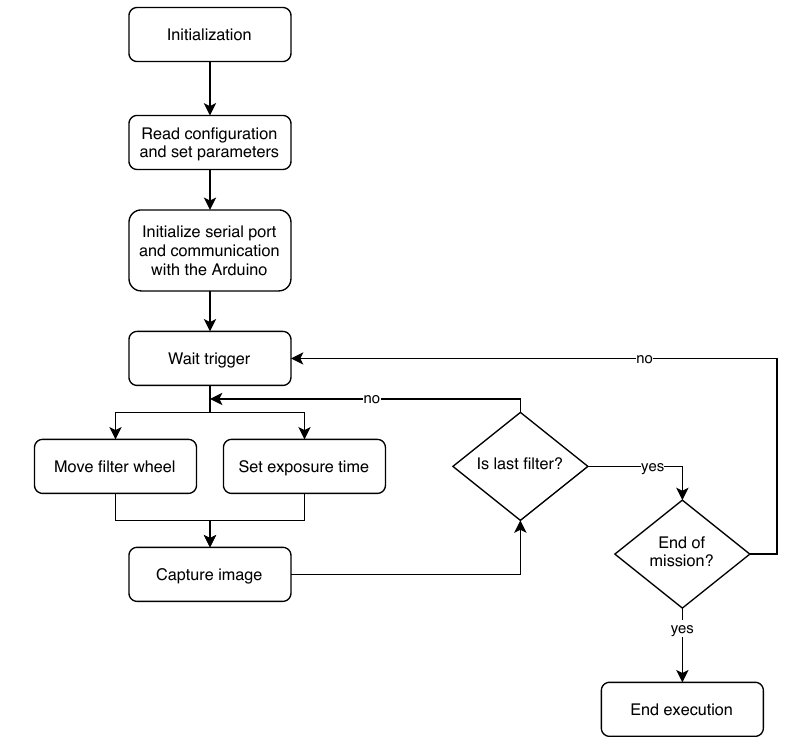
Figure 6. Main Application